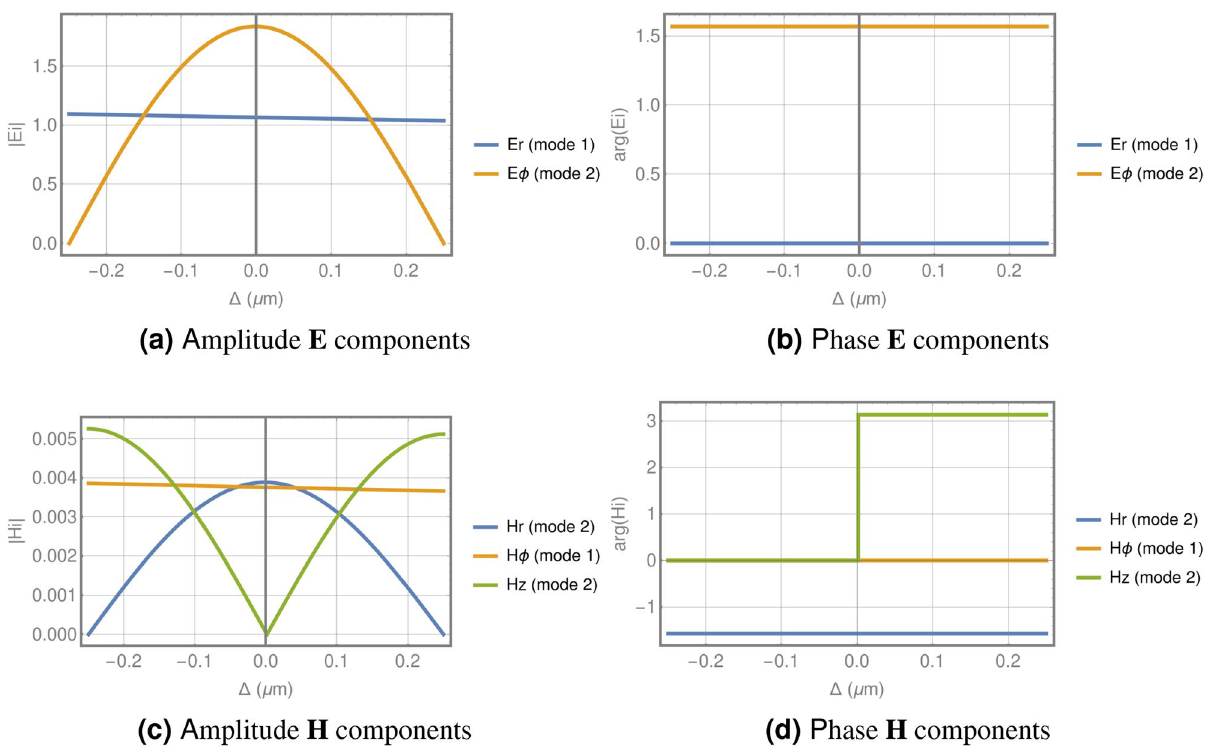
Figure 2. Amplitude and phase for the components of the electric and magnetic fields of the guided modes respect to the center of the guide